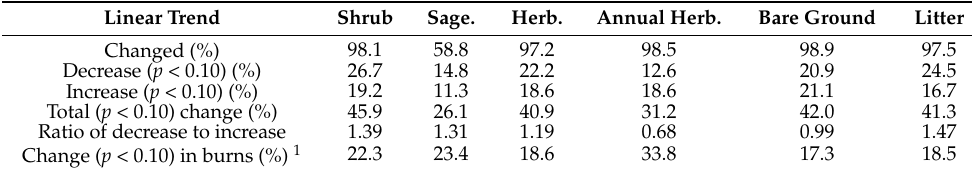
Figure 4. Fractional component cover averaged yearly across the study area (black line) and in areas unburned across the study period (gray line) ( A – F ). Mean growing season (April–September, black line) and non-growing season (October– March, gray line) climate variables for 1985–2018 ( G – I ). Significance is indicated as *, **, and *** for significance levels p < 0.10, p < 0.05, and p < 0.01, respectively. Table 1. Summary statistics for linear trends in fractional component cover observed over the 1985–2018 study period. Total percentage of pixels with any change in component cover, significant ( p < 0.10) decrease, significant increase, with significant change in either direction, and the ratio of significant decrease pixels to significant increase (where positive values indicate decrease is more